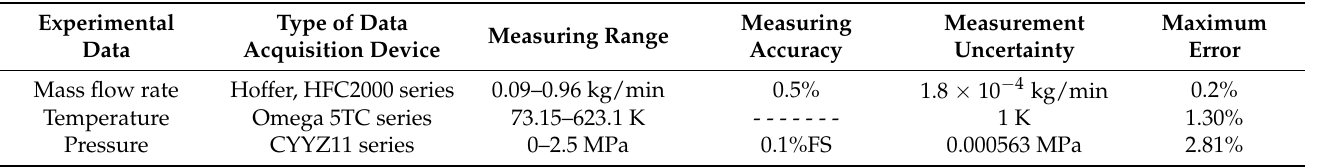
Table 1. Uncertainty analysis of experimental data.